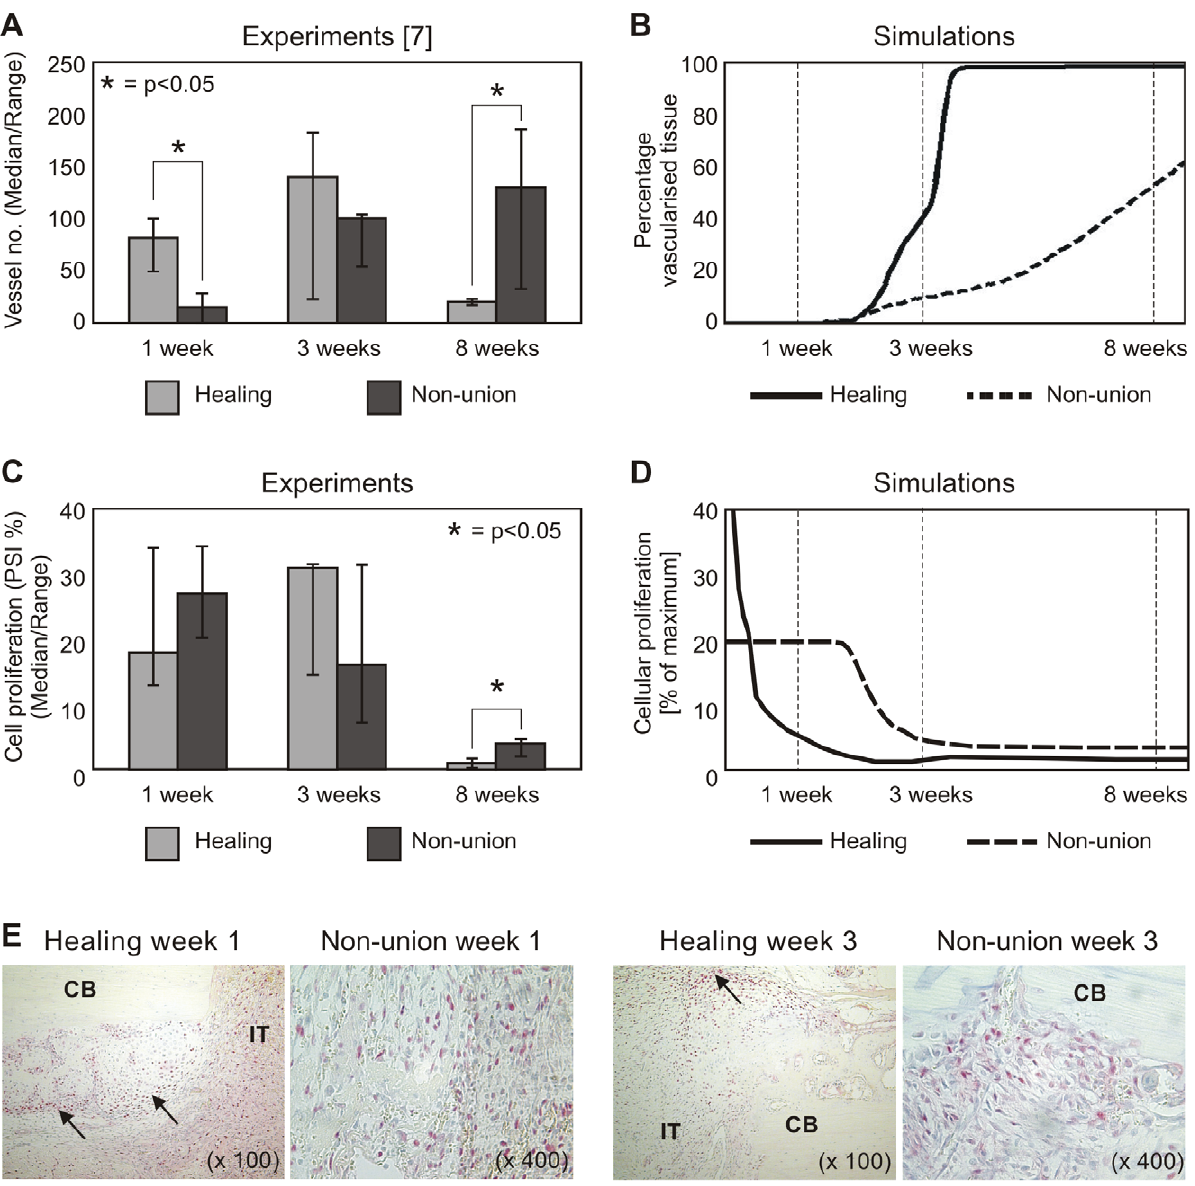
Figure 3. Vascularisation and cell proliferation in healing and non-union groups. ( A ) Comparison of the median number of blood vessels between the healing and non-union groups [7]. ( B ) Percentage of vascularised tissue in the callus as calculated by the mathematical model. ( C ) A comparison of the number of PCNA positive cells within the interfragmentary gap at 1, 3, 8 and 16 weeks post-osteotomy between healing and non- union groups. ( D ) Cellular proliferation for the healing and non-union set-ups, as calculated by the mathematical model. ( E ) PCNA expression indicating cell proliferation in the fracture area. For the healing group PCNA expression is found along the edge of callus formation in the periosteum (arrows) and within the interfragmentary tissue (IT) at POW1 (magnification 6 100) and along the callus ossification front (arrow) and within the interfragmentary tissue at POW3 (magnification 6 100). The non-union group shows PCNA stained cells in the interfragmentary gap at POW1 (magnification 6 400) and PCNA positive cells surrounding areas of active bone resorption at POW3 (magnification 6 400). CB=cortical